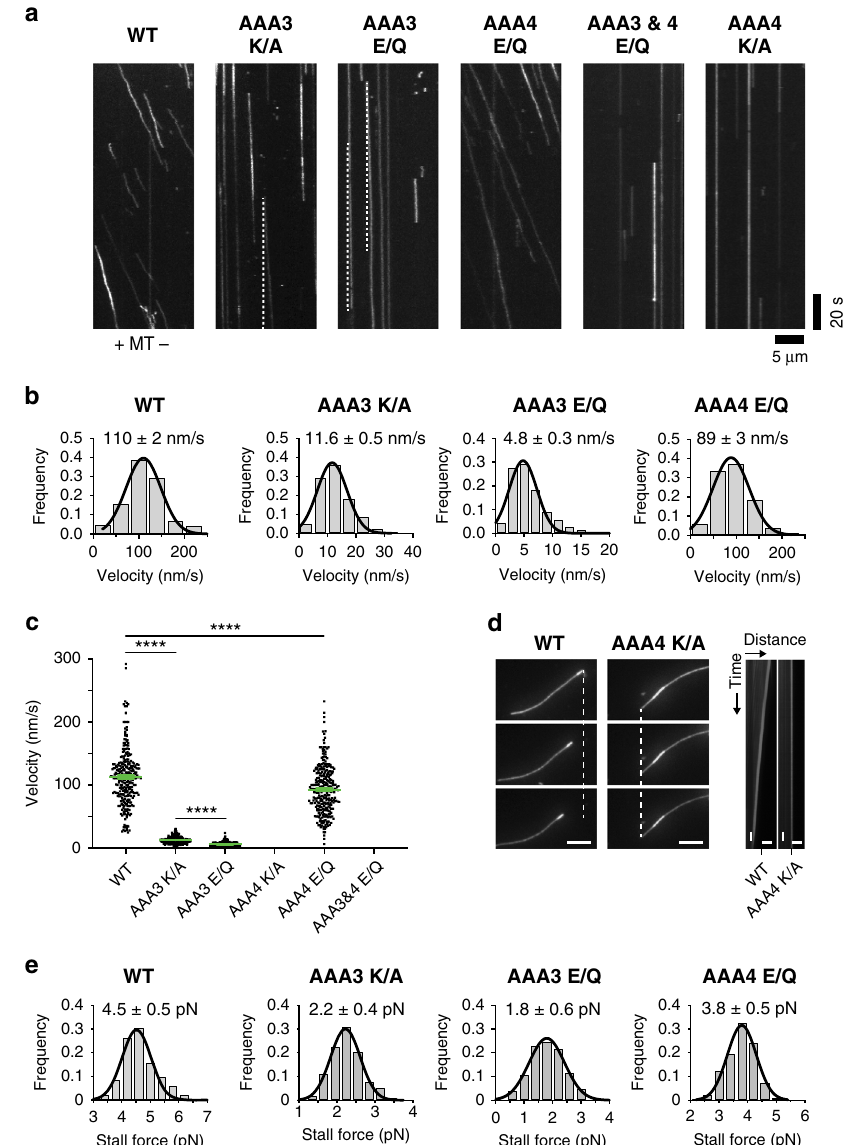
Fig. 2 AAA4-ATP binding is essential for dynein motility. a Antibody-dimerized WT Dyn1 331kDa moves processively in the single-molecule TIRF assay. Diagonal lines in the kymograph represent dimerized molecules that are moving over time. Preventing ATP binding (K/A) or ATP hydrolysis (E/Q) by AAA3 dramatically slows down dynein motion (dashed white lines serve as visual guides to identify slow moving mutants). In contrast, preventing ATP hydrolysis by AAA4 only slightly reduces dynein speed. Strikingly, preventing ATP hydrolysis by both AAA3 and AAA4 or preventing AAA4-ATP binding only, completely abolishes dynein motion (experiments were repeated 3 and 5 times, respectively, with the same results). b Fitting the WT velocity histograms with a Gaussian fi t (black line), returns a mean velocity of 110 ± 2 nm/s (±SEM; N = 284; obtained from n = 6 independent experiments). Analysis of the AAA3 mutants con fi rms the low velocities suggested by the kymographs: 11.6 ± 0.5 nm/s (±SEM; N = 243; n = 5) for the Dyn1 331kDa AAA3 K/A mutant and 4.8 ± 0.3 nm/s ( N = 295; n = 6) for the Dyn1 331kDa AAA3 E/Q mutant. The Dyn1 331kDa AAA4 E/Q mutant moves with a mean velocity of 89 ± 3 nm/s ( N = 307; n = 5). c Comparison of the WT GFP-Dyn1 331kDa , AAA3 K/A GFP-Dyn1 331kDa , AAA3 E/Q GFP-Dyn1 331kDa , and AAA4 E/Q GFP-Dyn1 331kDa mean velocities (±SEM). Statistical signi fi cance was determined using an unpaired Welch ’ s t test (**** p < 0.0001). d Kymograph analysis of TMR-labeled and polarity-marked MTs bound to a cover glass via surface-anchored WT Dyn1 331kDa and Dyn1 331kDa AAA4 K/A in the presence of 1 mM ATP. Left: image sequence showing the gliding of a MT with the bright minus-end lagging, revealing the minus-end-directed activity of WT Dyn1 331kDa . Middle: image sequence of an immobile MT bound rigidly to the cover glass via the Dyn1 331kDa AAA4 K/A mutant, demonstrating that this mutant is able to bind MTs but incapable of gliding them. Right: kymographs of image sequences of 1,200 images each with representative images shown on the left. The depicted horizontal scale bars correspond to a distance of 5 μ m and the vertical scale bars to a time period of 10 s. e Histogram of stall forces measured for homodimeric full-length WT GFP-Dyn1 471kDa , AAA3 K/A GFP-Dyn1 471kDa , AAA3 E/Q GFP-Dyn1 471kDa , and AAA4 E/Q GFP-Dyn1 471kDa (mean ± SD). The number of events for each histogram: WT, 189; AAA3 K/A, 119; AAA3 E/Q, 130; and AAA4 E/Q, 189. Source data are provided as a Source Data fi